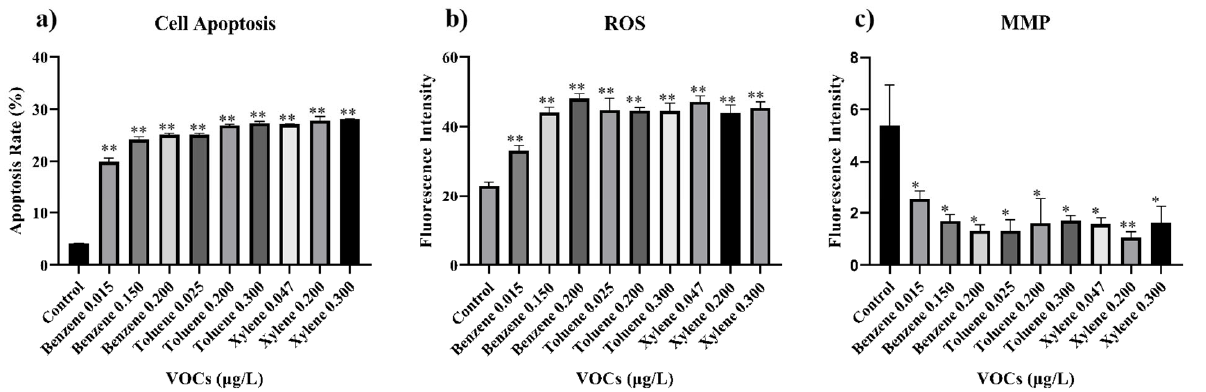
Figure 3. The oxidative stress effects of BTX on BEAS-2B cells were tested at different concentrations by examining ( a ) cell apoptosis, ( b ) reactive oxygen species (ROS), and ( c ) mitochondrial membrane potential (MMP) after 24 h of incubation. These factors served as indicators of oxidative stress effects. The ratio of DMSO to cell culture medium is 0.05%. * p < 0.05 and ** p < 0.01.